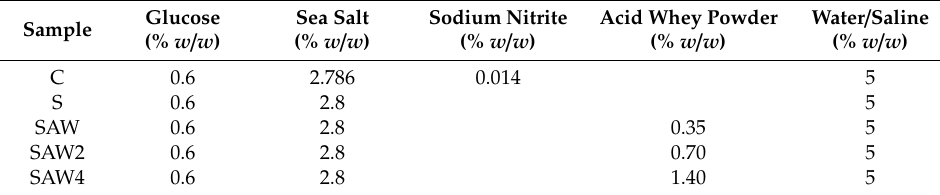
Table 1. Additives used for each variant of